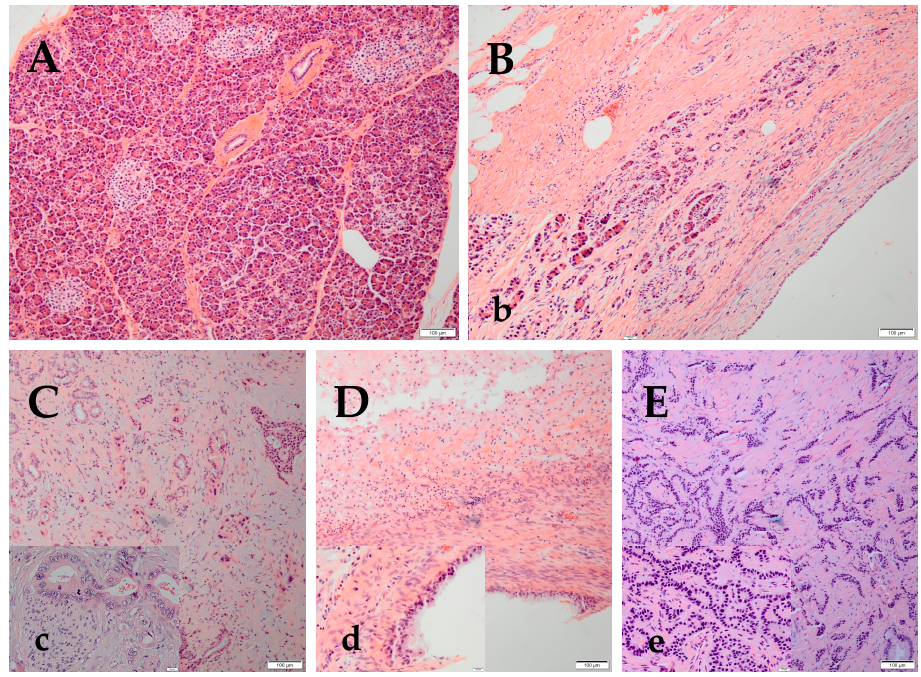
Figure 1. Representative pictures from hematoxylin and eosin staining of normal pancreatic parenchyma, chronic pancreatitis (CP), pancreatic adenocarcinoma (PA), mucinous pancreatic cyst and pancreatic neuroendocrine tumors (NET). ( A ) Normal pancreas shows acini and interlobular ducts (exocrine) and islets of Langerhans (endocrine) (10 × ) ( B ) CP shows loss of acini and ductal tissue, as well as periductal fibrosis (10 × ). ( b ) The thumb image is a lower magnification of CP, depicting residual islets and interlobular ducts with flattened epithelium (40 × ). ( C ) PA is composed of small glands and malignant cell clusters with hyperchromatic nuclei invading in a desmoplastic stroma (10 × ). ( c ) The high magnification (40 × ) of a moderately differentiated PA shows glands composed of tall columnar cells with abundant cytoplasm. Perineural invasion, one of the characteristics of PA, is also seen here. The tumoral nuclei are large, with irregular nuclear membrane, frequently vesiculated chromatin, with numerous chromocenters and occasional proeminent, cherry red nucleoli. ( D ) The pancreatic mucinous cyst is composed of cells which contain intracytoplasmic mucin and fibrosed stroma (10 × ). ( d ) The high magnification (40 × ) shows mucin secreting glandular cells lining a benign mucinous cyst of pancreas (40 × ). ( E ) NET is composed of cells forming trabeculae, cords and ribbons of neoplastic cells (10 × ). ( e ) The high magnification (40 × ) photo shows a well differentiated NET of the pancreas; the cells are small to medium in size, with eosinophilic to amphiphilic and finely granular cytoplasm. The nuclei are monotonous, uniform, eccentrically located, round-to-oval, with “salt and pepper” (finely stippled) chromatin and no conspicuous